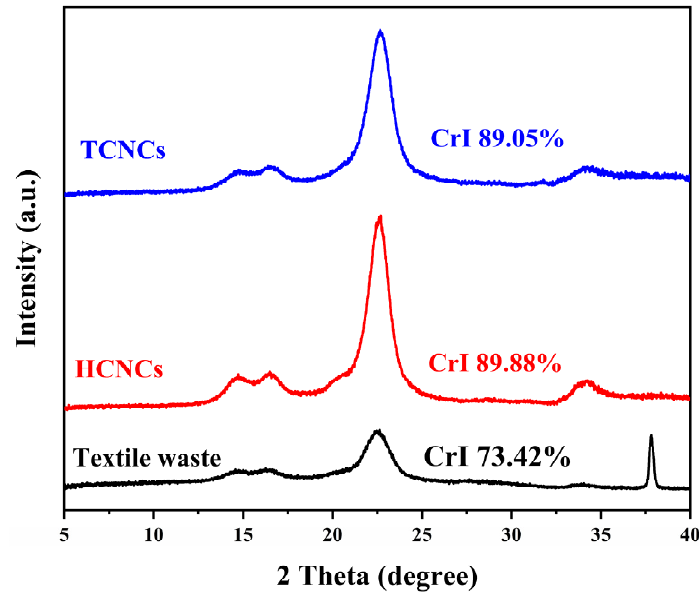
Figure 3. X-ray diffraction (XRD) patterns and crystallinity index (CrI) of textile waste, HCNCs, and TCNCs.